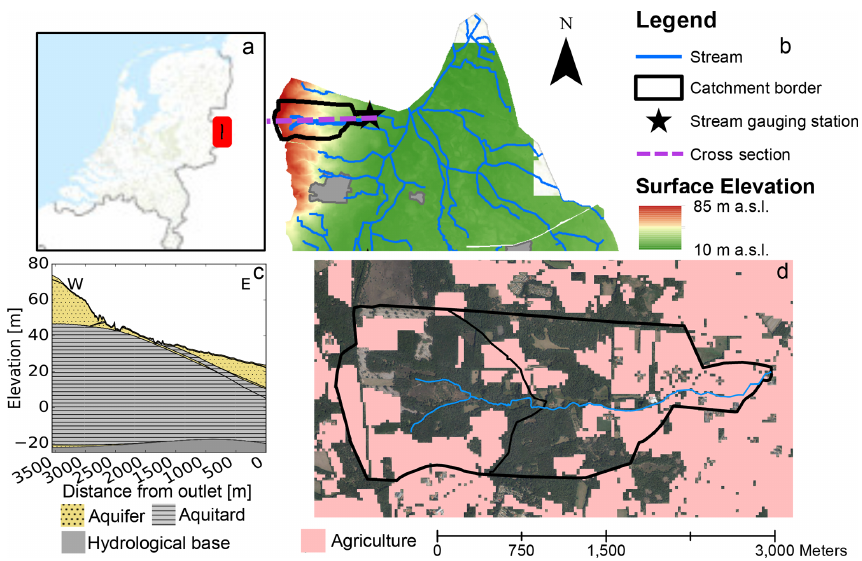
Figure 1. Location of the study area (a, b) , model conceptualization (c) , and the location of agricultural fields in the year 2007 (d) . Back- ground maps and digital elevation model (DEM) are from PDOK (Public Services on the Map; https://www.pdok.nl/datasets, last access: 21 March 2019). Table 1. Overview of the collected chloride and nitrate measurements. Location Parameters Period Source Total Upstream Cl, NO 3 1969–1981 Higler et al. (1981) 15 Upstream Cl, NO 3 1992 Hoek (1992)